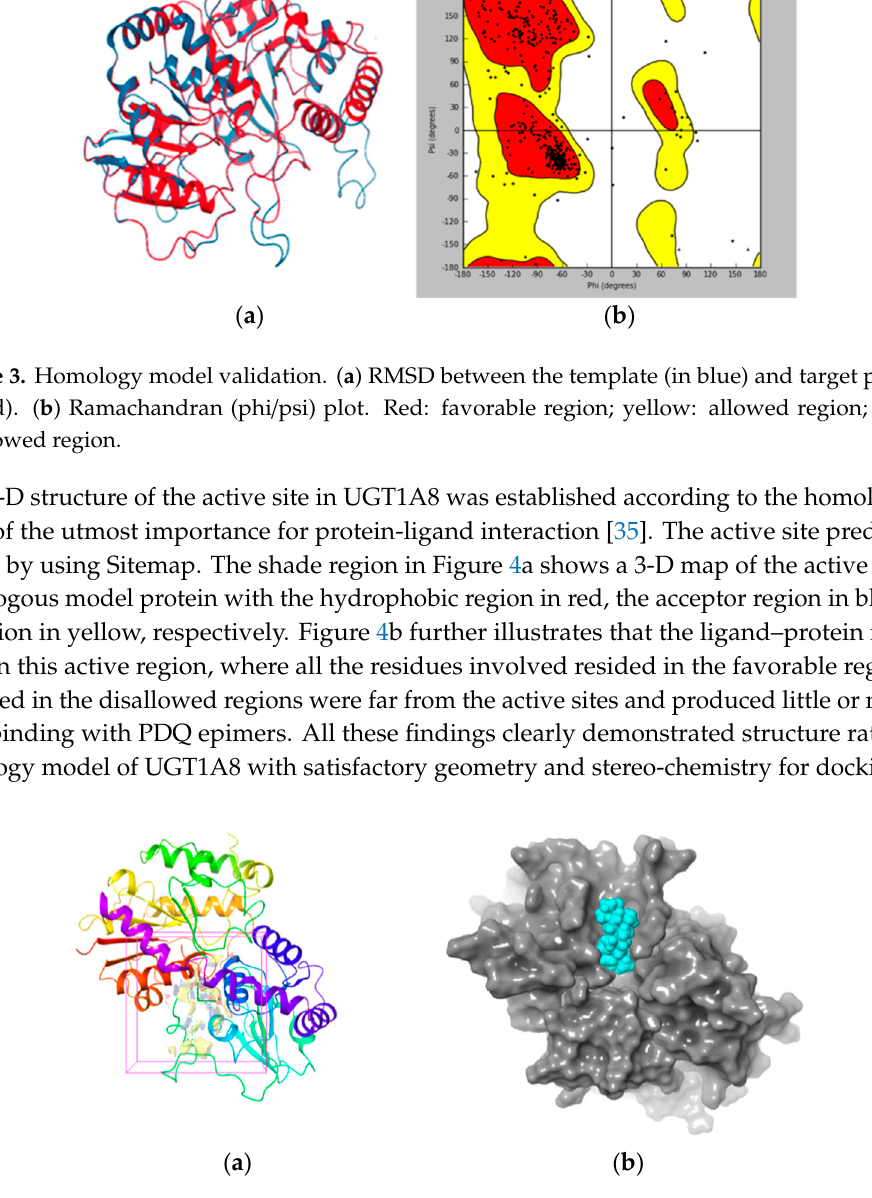
Figure 4. ( a ) Three-dimensional structure of active site within the homology model of UGT1A8 (region in the shadow). Stripe structure: the homology model of UGT1A8; Red: the hydrophobic region; blue: the acceptor region; yellow: the ligand region. ( b ) 3-D map of interaction between PDQ and UGT1A8. Gray region: UGT1A8; blue region: PDQ.